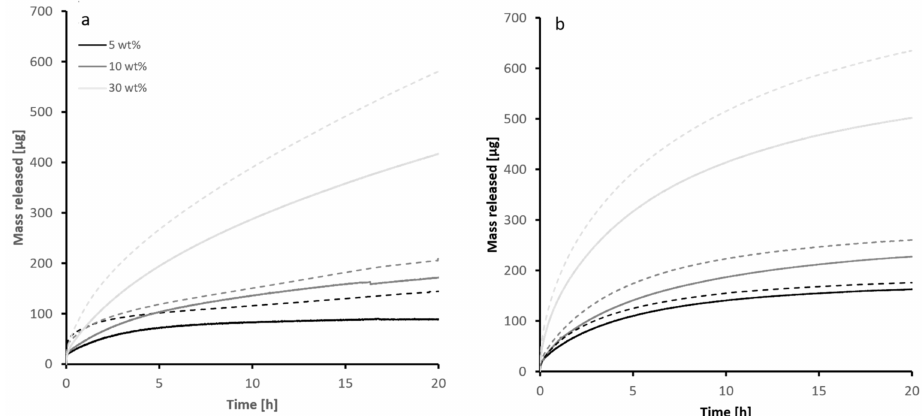
Figure 2. Experimental data for the release of thyme oil ( a ) and rosemary oil ( b ) over time. Grayscales represent different loadings.